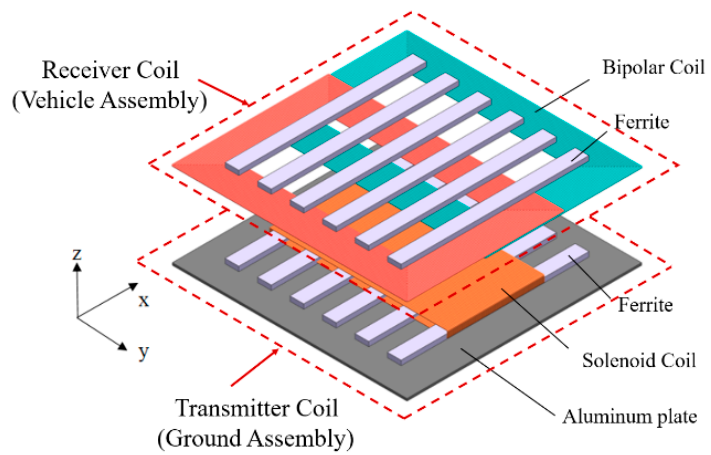
Figure 5. Proposed transformer structure.